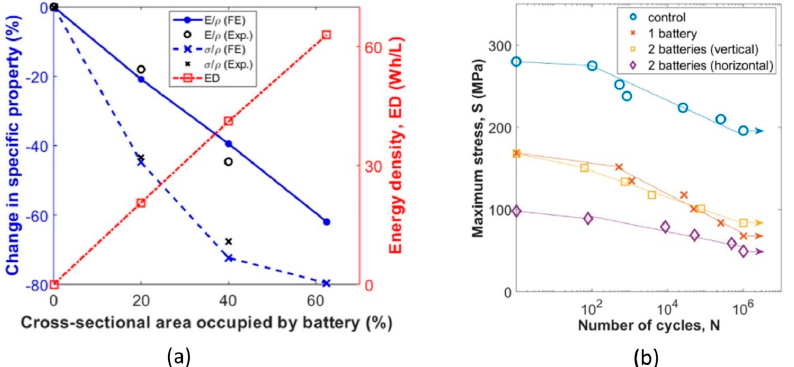
Figure 14. Compressive behavior of laminated batteries [9]. ( a ) Quasi-static performance. ( b )